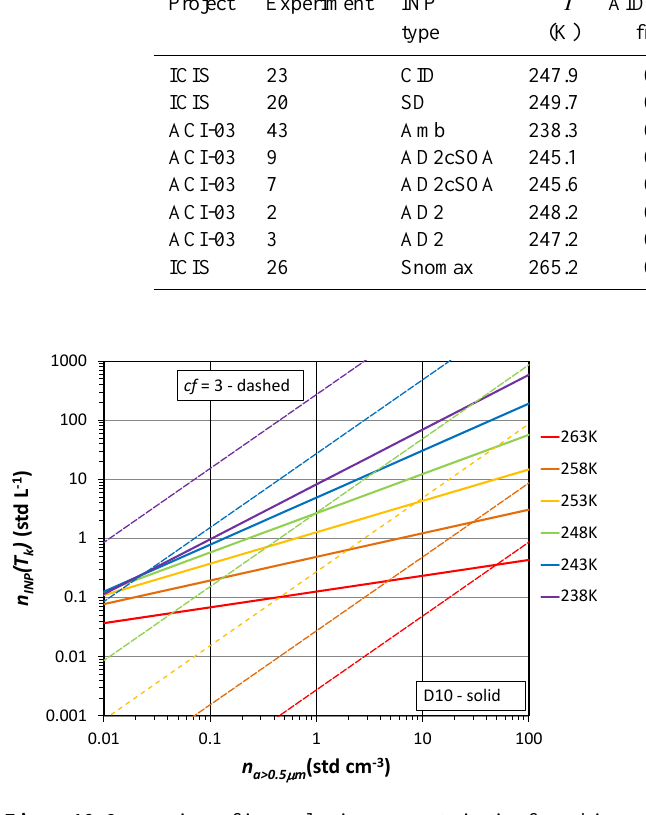
Table 1. Equivalent experiment comparisons between CFDC and AIDA. Project Experiment